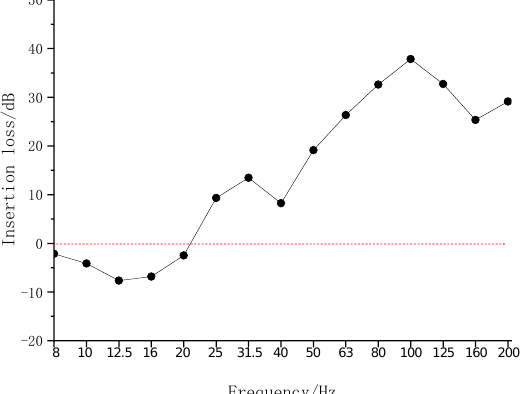
Figure 9. Insertion loss of tunnel wall acceleration